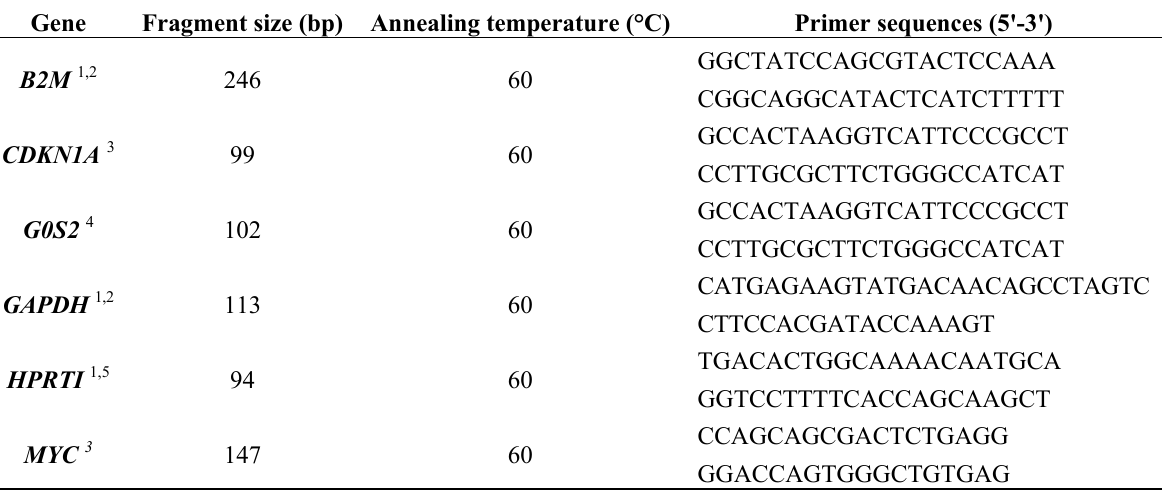
Table S1. Reverse transcription qPCR primers.